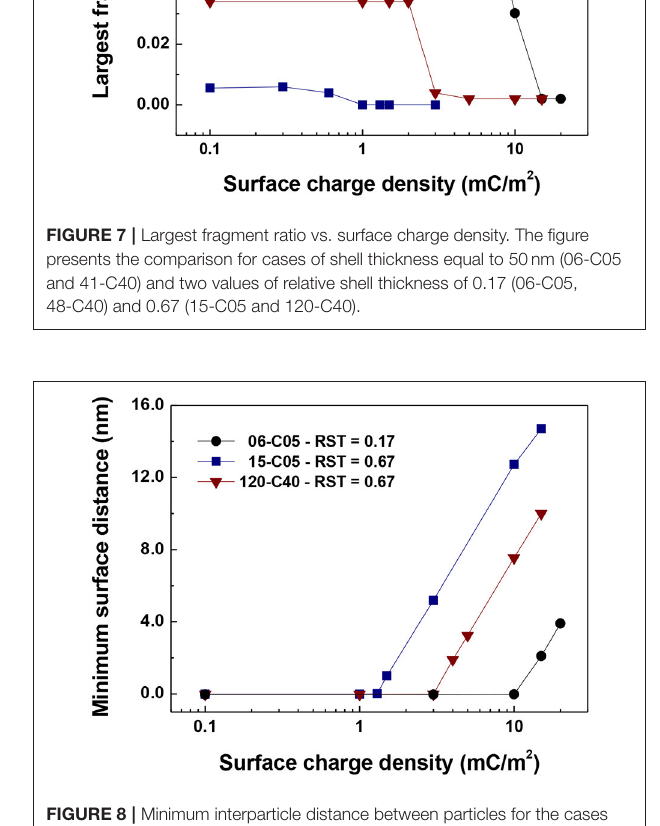
FIGURE 8 | Minimum interparticle distance between particles for the cases plotted in Figures 5 – 7 that show no contacts (15-C05 and 120-C40 and